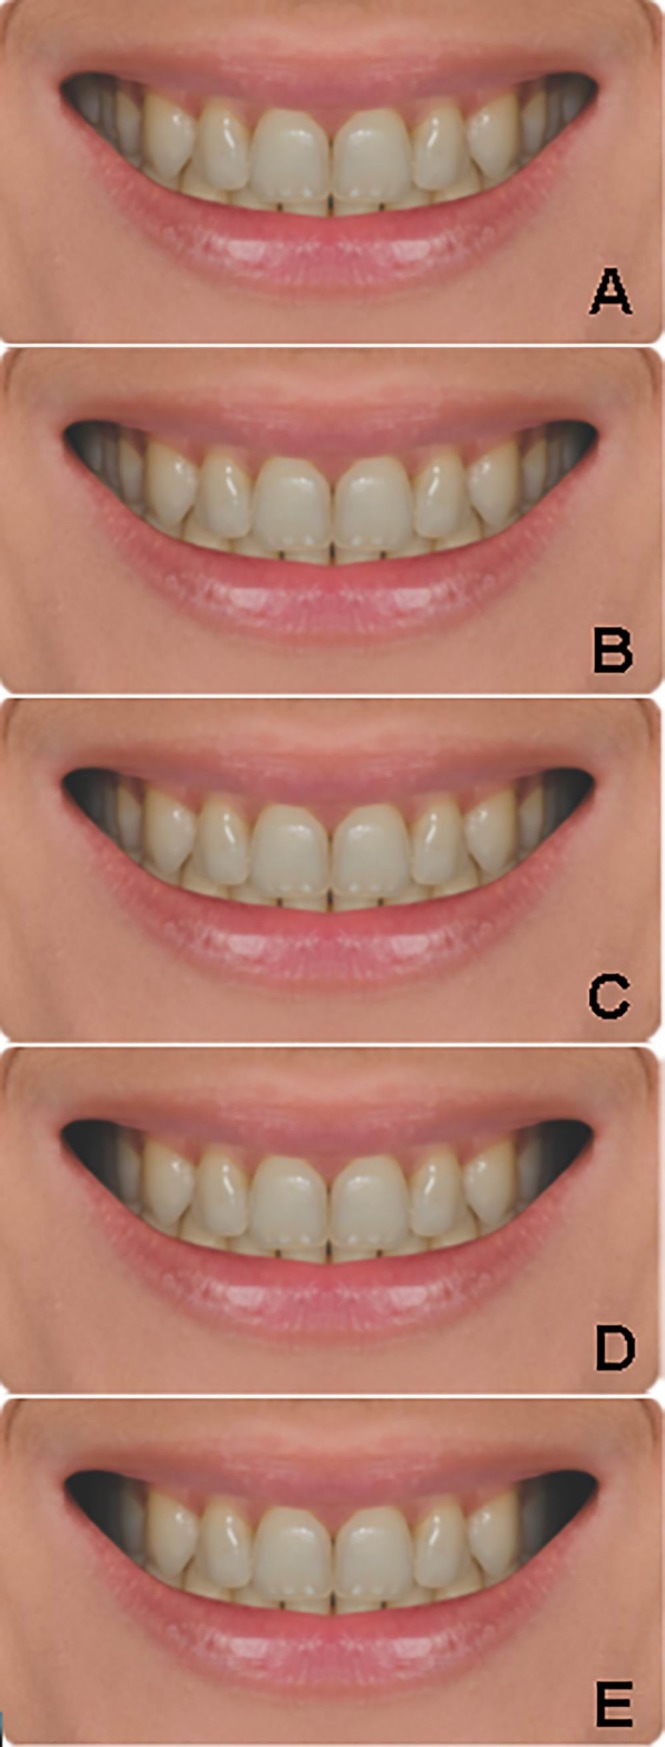
A sample series of images from the album used for the study.The modified feature is the width of the buccal corridor. A: the unmodified image. B-E: the buccal corridor widens by 1 mm steps up to + 4 mm (compared to the unmodified image).